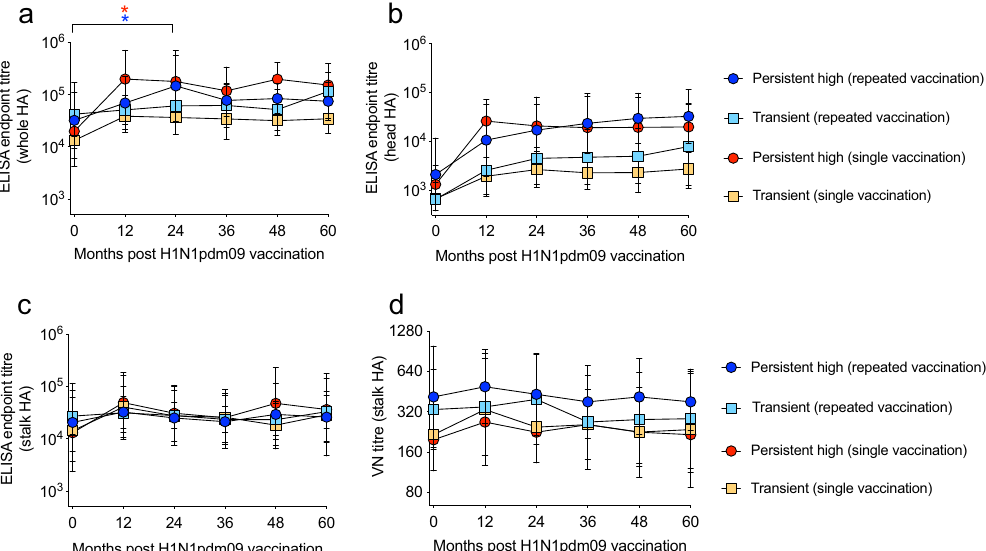
Fig. 3 No differences in HA-stalk-speci fi c antibodies between the persistent high and transient responders. The serum IgG binding to the HA protein of the H1N1pdm09 virus before each in fl uenza season were measured by the ELISA assay. Persistent high responders are presented as circles and transient responders as squares. Repeated vaccination is shown in blue and turquoise, and single vaccination is shown in red and orange. The endpoint titres are shown for antibodies binding to different domains of the HA protein: whole HA ( a ), HA head ( b ) and HA stalk ( c ). Functional neutralizing HA-stalk speci fi c antibodies were measured in the virus neutralization (VN) assay using a chimeric cH9/1N3 virus ( d ). Geometric mean titres and 95% con fi dence intervals are presented. Statistical differences between different time points were tested using two-way ANOVA with Tukey test for multiple comparisons. * P < 0.05, ** P <